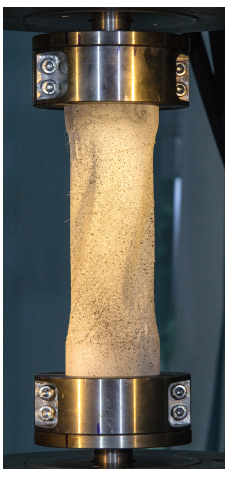
Figure 3. Torsion test of a tubular specimen with ap- plied speckle pattern for full-field strain measurement and visible torsional buckling of the specimen.